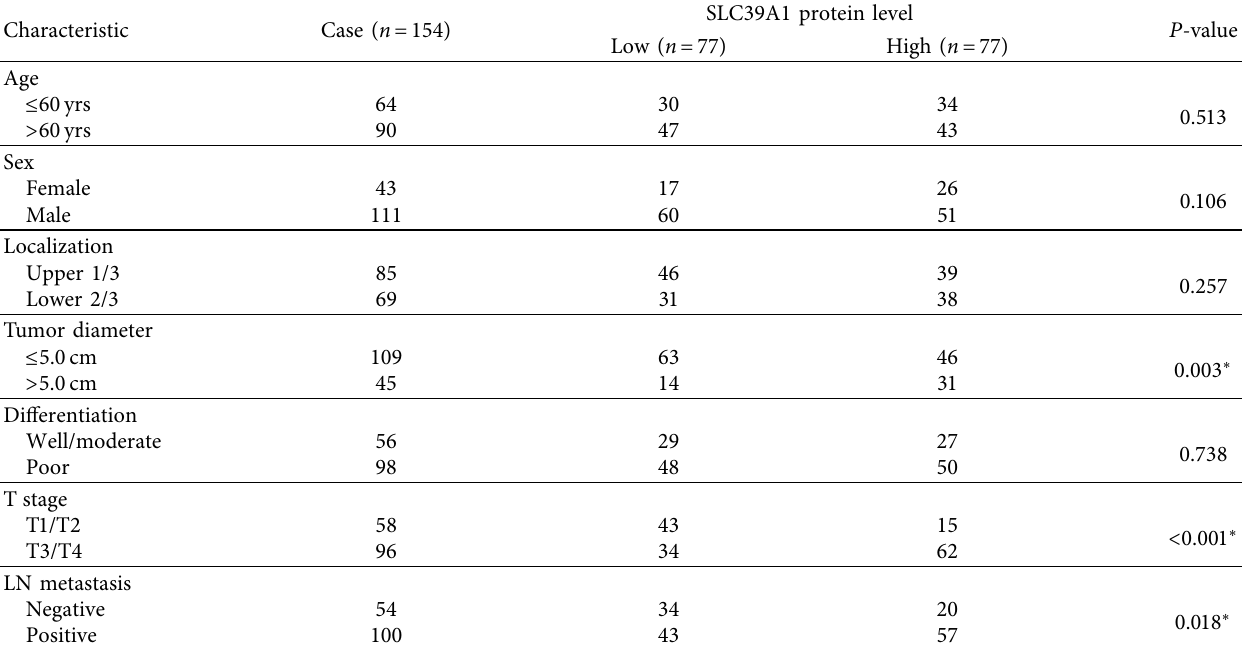
Figure 1: Upregulated expression of SLC39A1 in gastric adenocarcinoma. (a) Te mRNA level of SLC39A1 was extracted from TCGA and GTEx datasets and plotted by GEPIA server (https://gepia.cancer-pku.cn/index.html) according to transcripts per million (TPM). Te data showed that SLC39A1 mRNA level was higher in gastric adenocarcinoma (GAC) tissues than that in normal stomach tissues. (b) Kaplan–Meier progression-free survival and overall survival (c) curves were plotted using the K-M plot server (https://kmplot.com/ analysis/) according to the mRNA level of SLC39A1, which implied that higher SLC39A1 helped predict worse progression-free survival and overall survival. (d) Representative IHC image showed low expression of SLC39A1 protein in adjacent stomach tissues. (e) Representative Table 1: Correlations between SLC39A1 protein level with patients’